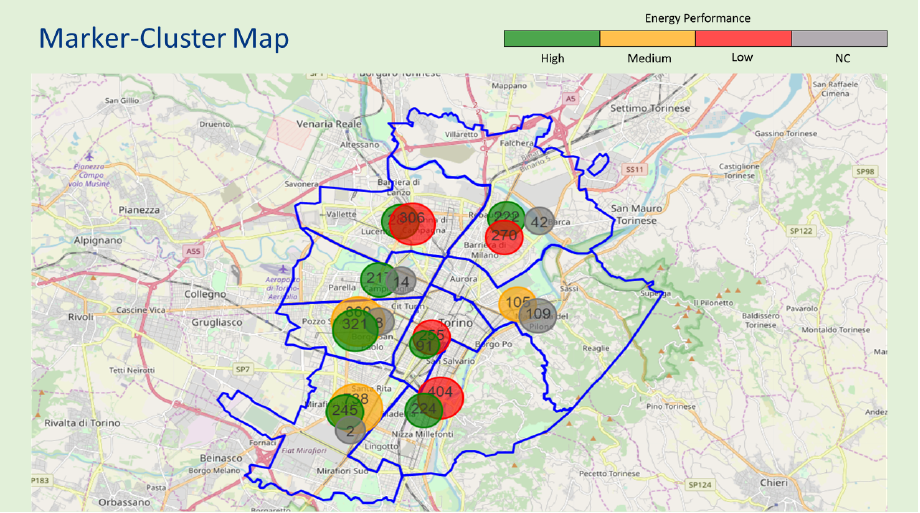
Figure 15. Example of marker-cluster map at city